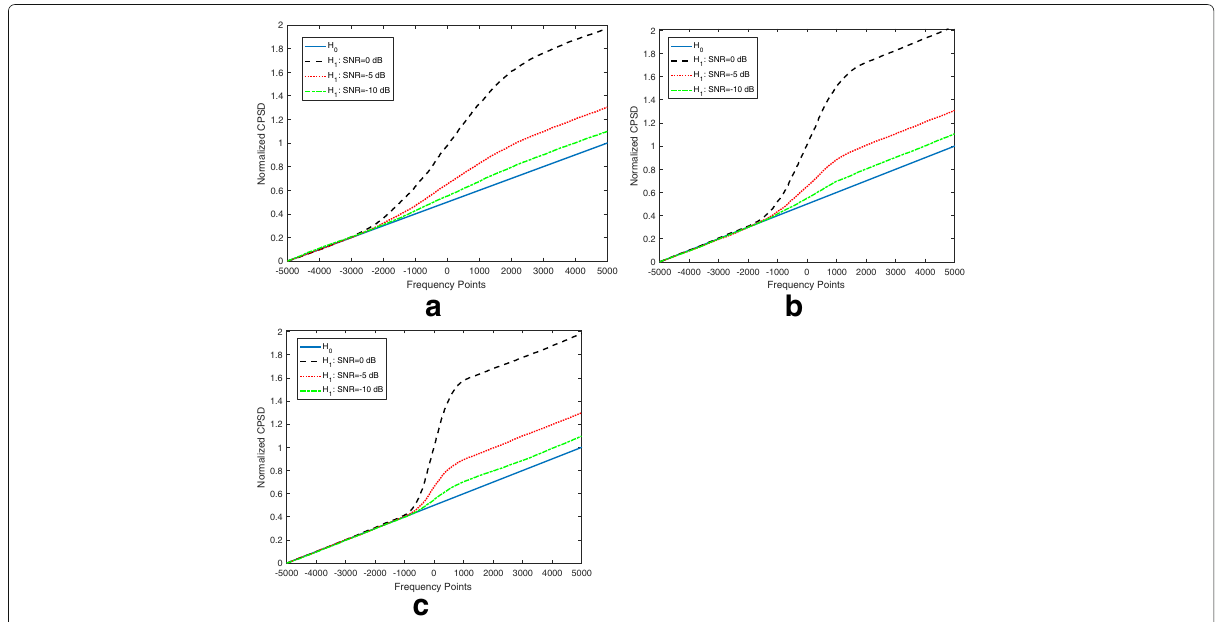
Fig. 2 The normalized CPSD shapes for N = 10000 samples and several values of N s and SNR: raised cosine pulse-shaping filter. a N s = 2 sps. b N s = 4 sps. c N s = 8 sps